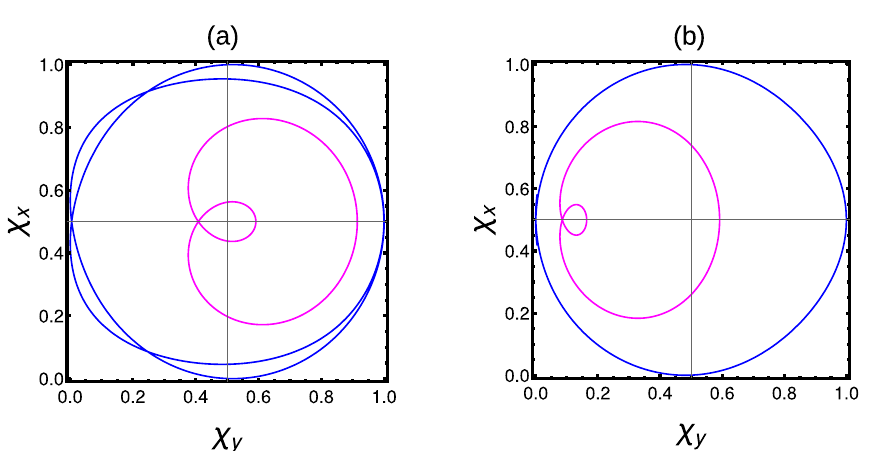
Figure 5. (Color online) Winding vector analysis of Hermitian extended-range SSH chain with two neighbors. The blue and magenta curves represent the zero temperature and T 2 case ( b ) W 1 respectively. ( a ) W = =